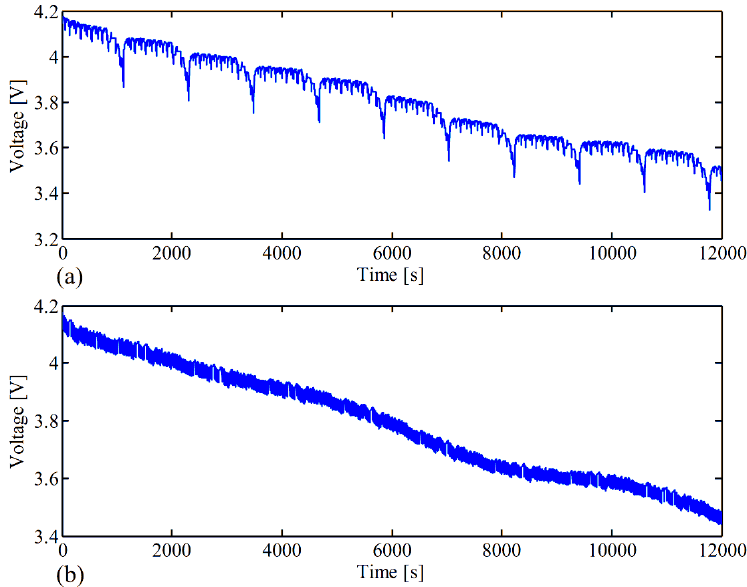
Figure 6. Voltage profile: ( a ) NEDC; and ( b ) FUDS.